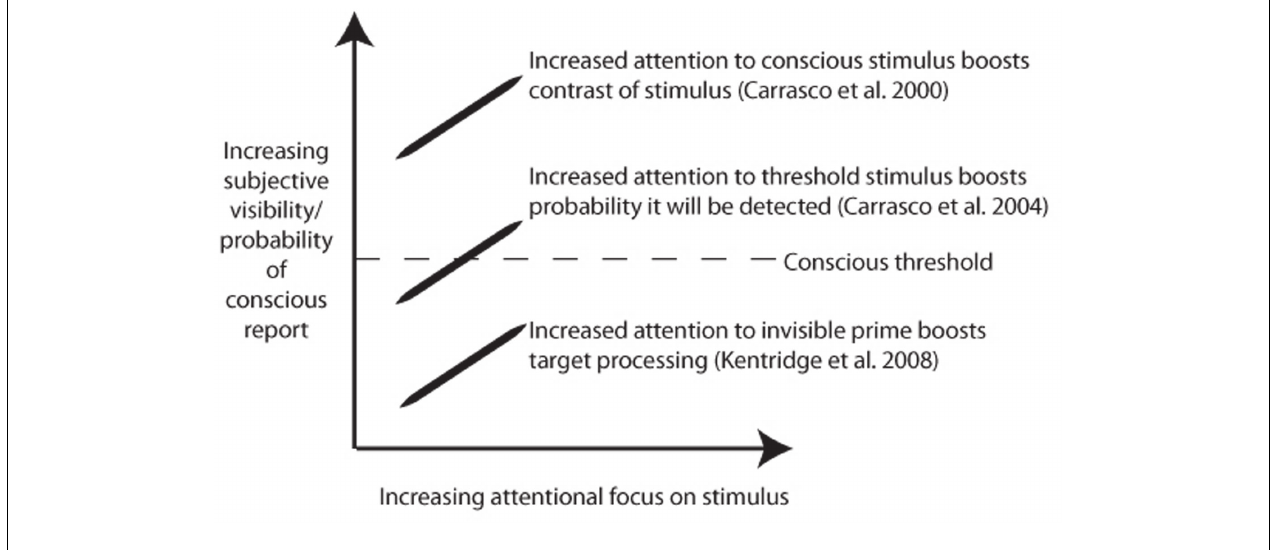
independence of attention and consciousness, it is instead possible that in this and all other cases there is a strong positive correlation between attention and